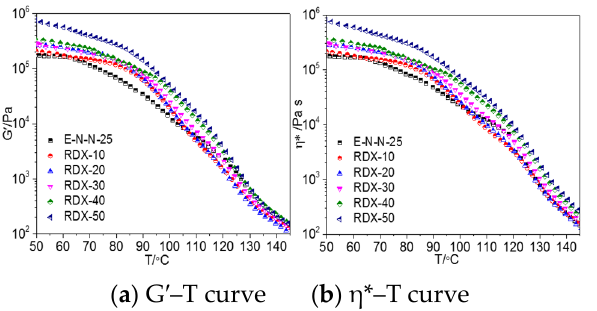
Figure 6. G ′ –T and η *–T curves of model propellants with different RDX contents ( γ = 1%, ω = 1 rad/s).